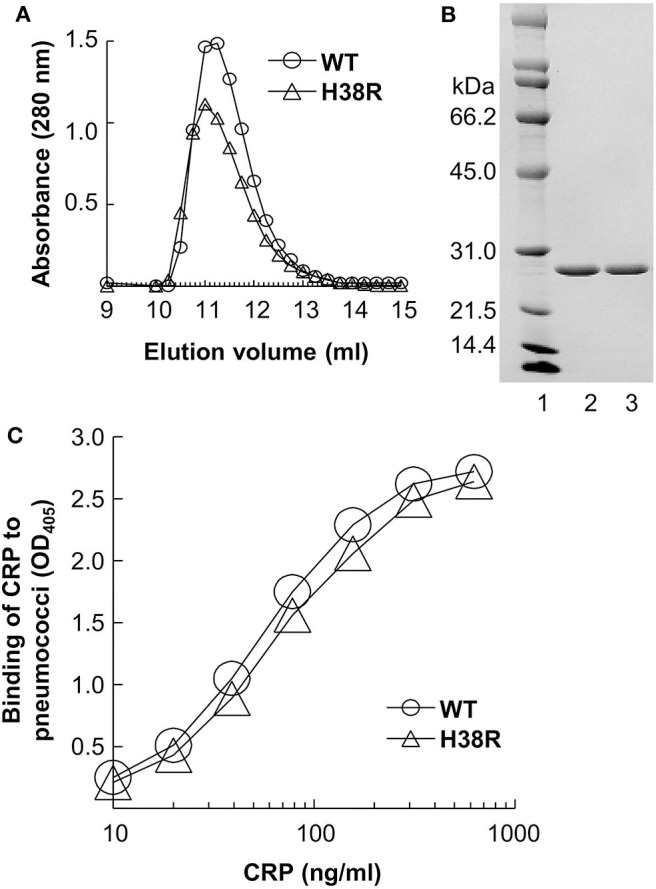
Overall pentameric structure of H38R CRP. A representative of three experiments is shown. (A) Elution profiles of CRP from the gel filtration column are shown. CRP in TBS containing 2 mM CaCl2 was applied to the column and eluted with the same buffer. Sixty fractions (0.25 ml) were collected and protein measured (A280) to determine the elution volume of CRP. (B) Denaturing SDS-PAGE of CRP. A Coomassie brilliant blue-stained gel (lane 2, WT CRP; lane 3, H38R CRP), is shown. (C) Binding of CRP to pneumococci. Microtiter wells were coated with pneumococci. CRP diluted in TBS-Ca was added to the wells. Bound CRP was detected by using an anti-CRP antibody. Color was developed and the OD was read at 405 nm.